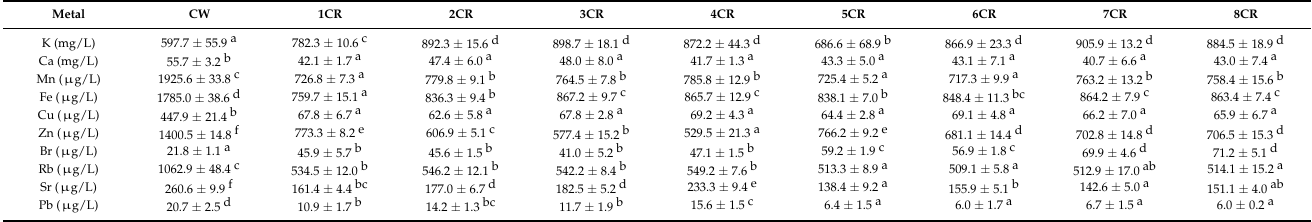
Significant differences ( p < 0.05) between the samples are indicated by different superscript letters within the row, from a–f; the lowest concentrations marked with letter a (ANOVA. Fisher’s LSD test). Abbreviations: CW—initial conventional wine; CR—reverse osmosis retentate of the conventional wine; 1—2.5 MPa, with cooling; 2—3.5 MPa, with cooling; 3—4.5 MPa, with cooling; 4—5.5 MPa, with cooling; 5—2.5 MPa, without cooling; 6—3.5 MPa,